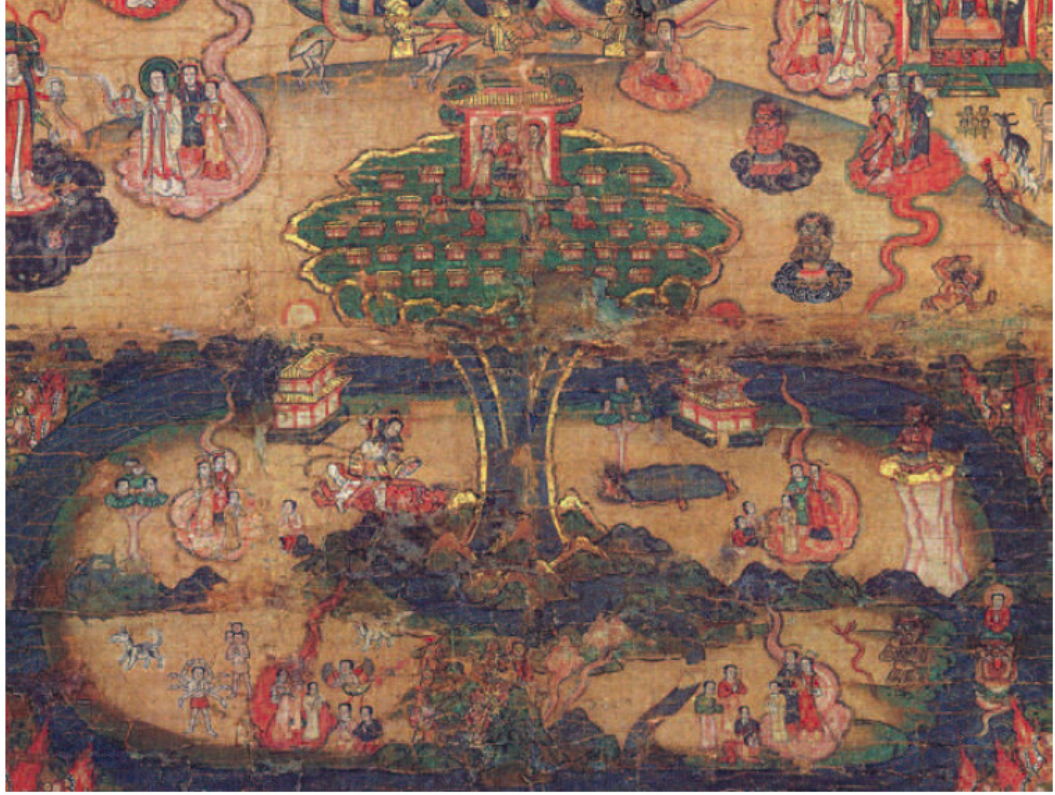
Figure 9. The Top of Sumeru mountain (Kósa 2016b, plate 2 [p. 182]).